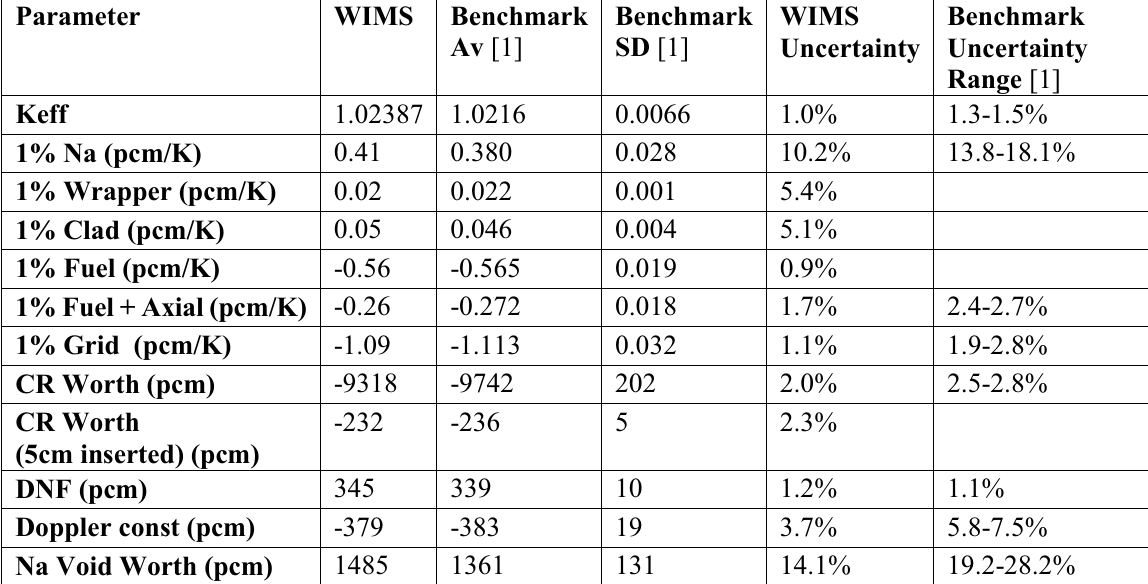
Table I.: WIMS results for SFR-UAM Medium Metallic Core compared to benchmark average reproduced from Ref.